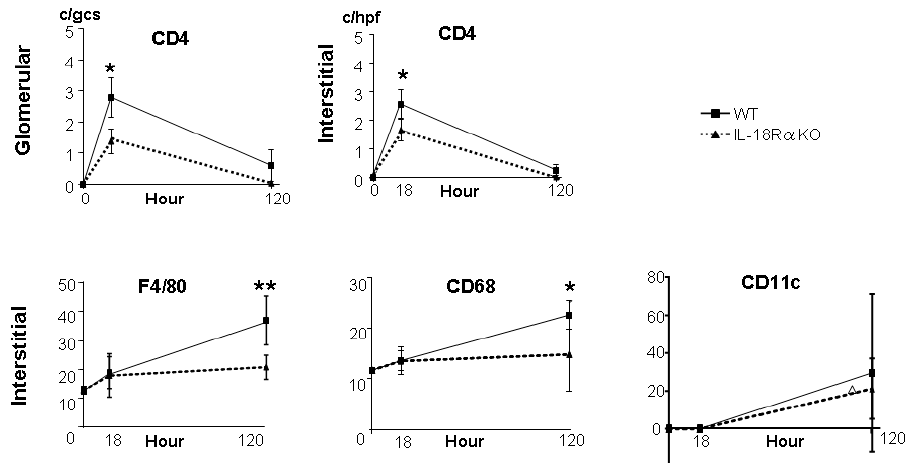
Figure 4. Effect of IL-18R α on the accumulation of inflammation cells in the glomerulus and interstitium after LPS injection The accumulation of CD4 + T cells, F4/80 + , CD68 + and CD11c + cells in the glomerulus and interstitium at 0 (KO and WT, n = 3), 18 ( n = 11 and n = 10) and 120 h ( n = 16 and n = 6) before and after LPS injection. The data are the mean ± SEM (* p < 0.05, ** p < 0.01, the cell numbers in IL-18R α KO vs. WT mice).